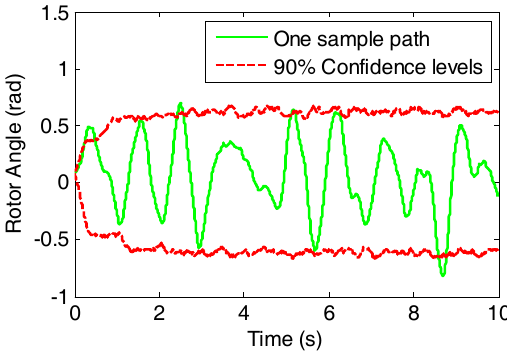
Figure 5. The Monte Carlo simulation process. EM: Euler-Maruyama.